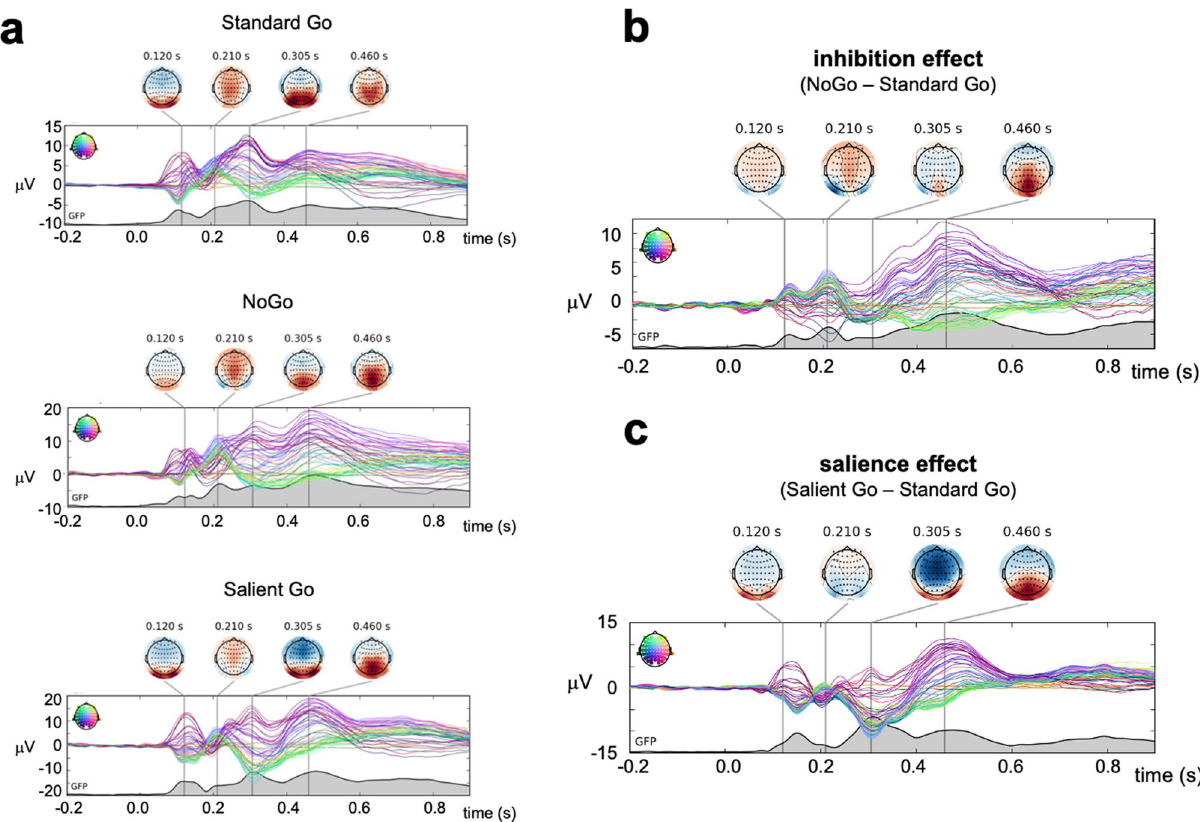
Figure 3. Grand-average ERPs at all EEG channels. Different channels are plotted in different colors, according to the color inset in the left upper corner of each plot. The global field power is shown at the bottom of each plot as a black line. All scalp topographic maps are scaled from –15 µV to + 15 µV. ( a ) Grand-average ERPs to all three conditions, shown separately. ( b ) Grand-average ERP difference waves representing the